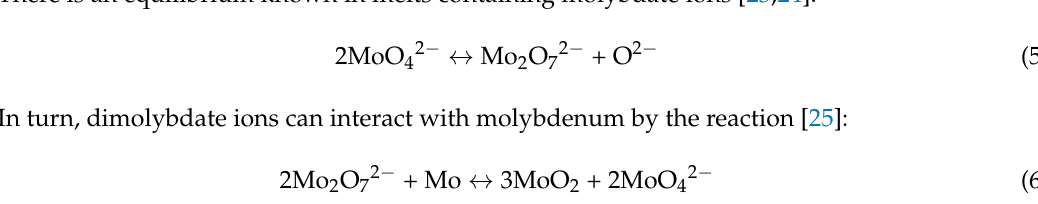
Figure 7. The morphology of the Mo 2 C coating on a molybdenum substrate obtained from the NaCl ‐